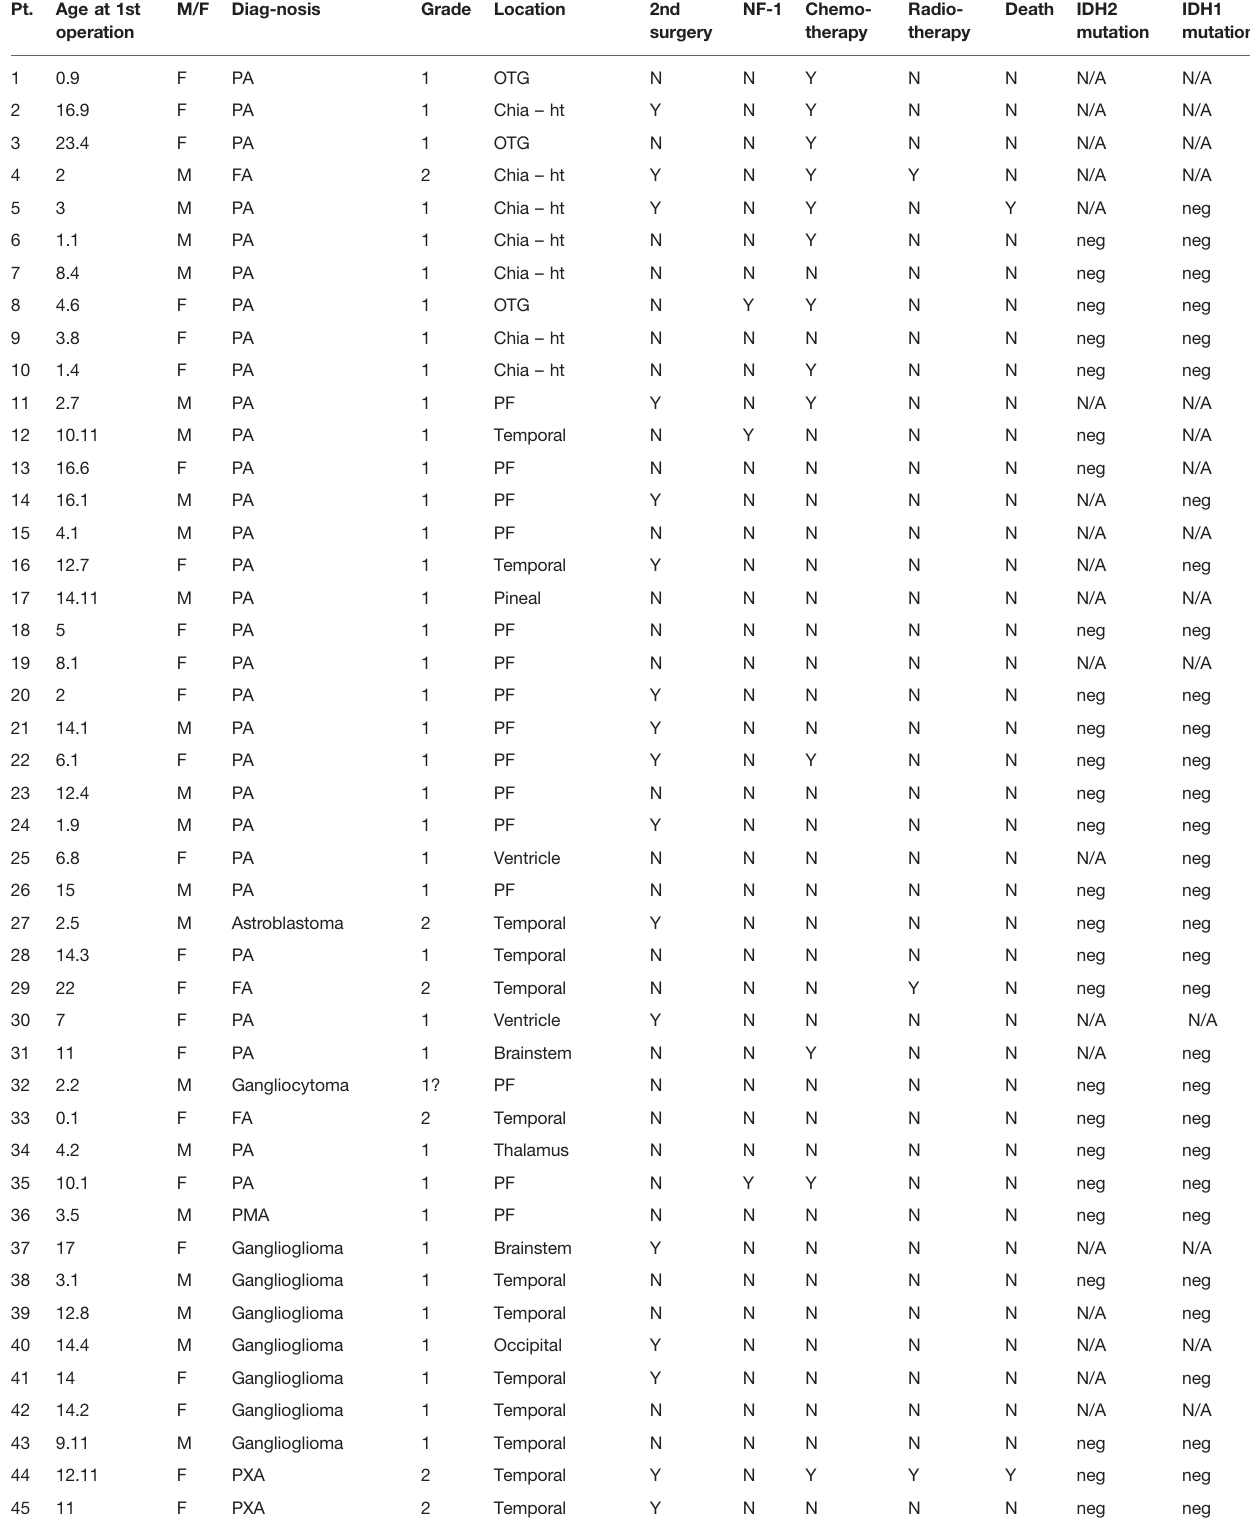
TABLE 1 | Patient data and analysis for IDH1/2 in gliomas grade I and grade II. Pt. Age at 1st